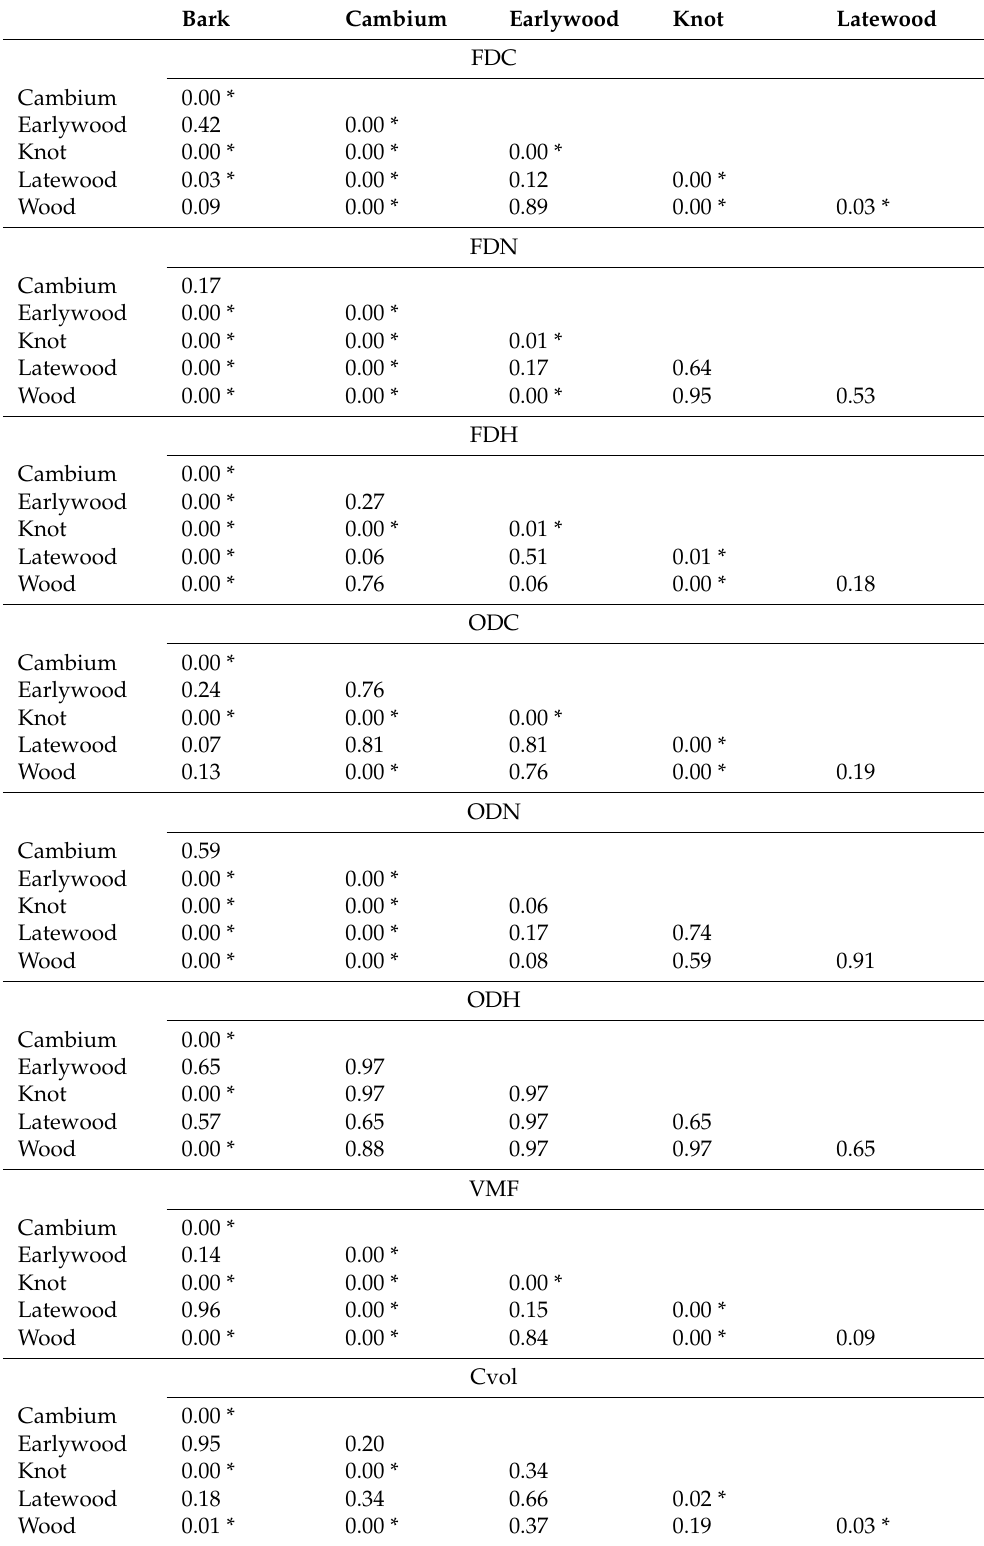
Table 2. Pairwise comparison of chemical content between tissues using Wilcoxon’s post hoc test. Bark